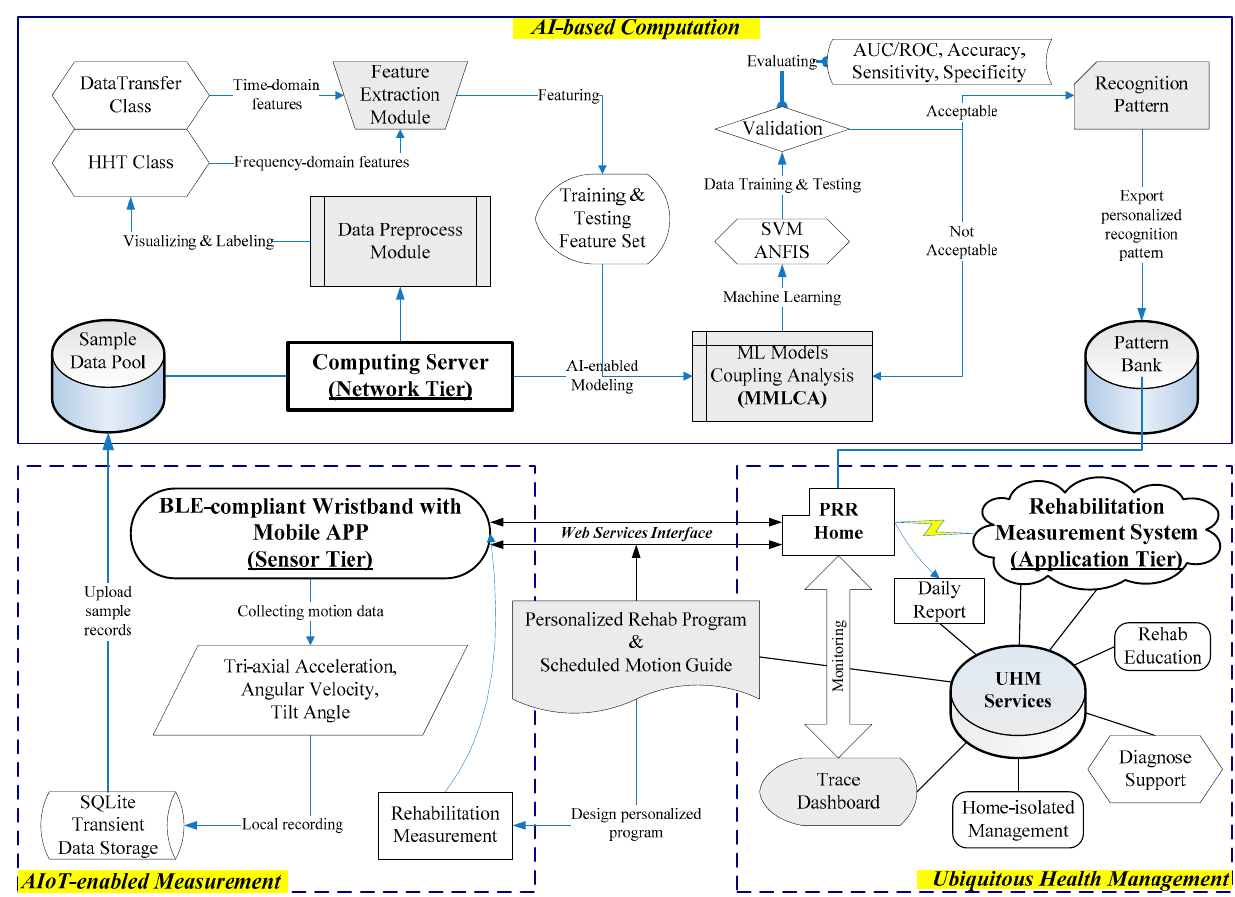
Figure 1. The three-tier infrastructure of the AIoT-enabled personalized rehabilitation recognition system